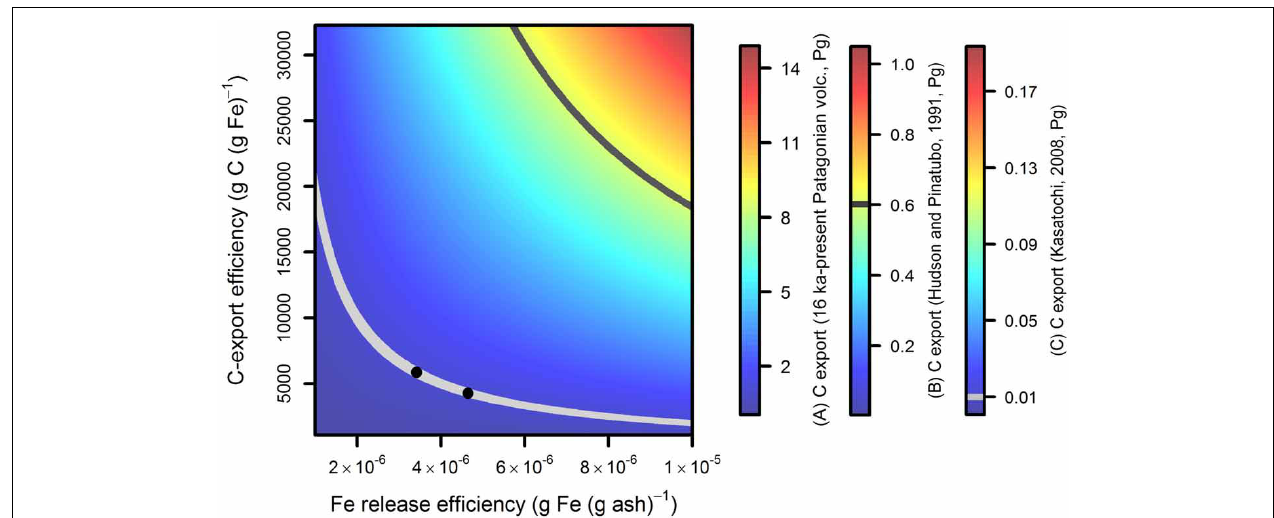
FIGURE 8 | Potential range of carbon sequestration calculated for applied bounds of Fe release from ash and carbon sequestration efficiency—highlighting the substantial uncertainty in estimating the potential for ash fertilization-induced carbon export. Ranges of Fe release and carbon sequestration efficiencies are described in Section: “Calculations of Potential Bounds for Ash-Fertilized Carbon Export.” These ranges have been applied to three estimates of ash fluxes to HNLC waters: (A) the 16.5kyr to present day flux to the Southern Ocean; (B) the 1991 eruptions of Pinatubo and Hudson; and (C) the 2008 Kasatochi